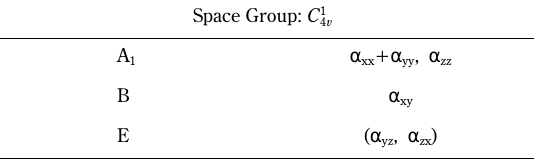
Table 1 Index for tetragonal system in space